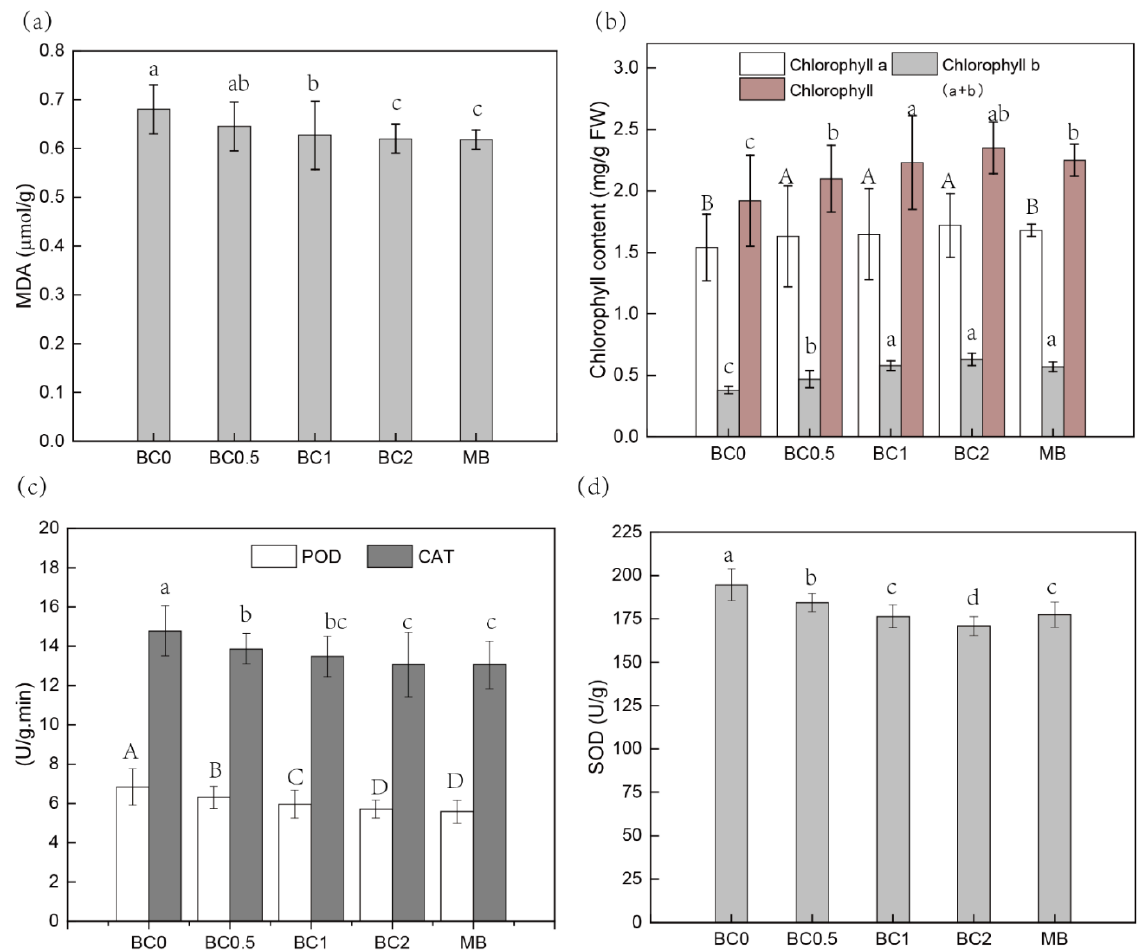
Figure 5. The physiological characteristics of pak choi. MDA ( a ); Chlorophyll content ( b ); POD and CAT activity ( c ); SOD activity ( d ). BC0, BC0.5, BC1, and BC2 mean as soil applied with T-BC of four rate (0, 0.5, 1, and 2% (w/w)); MB means as soil applied with biochar (2% (w/w)) from mango leaves.